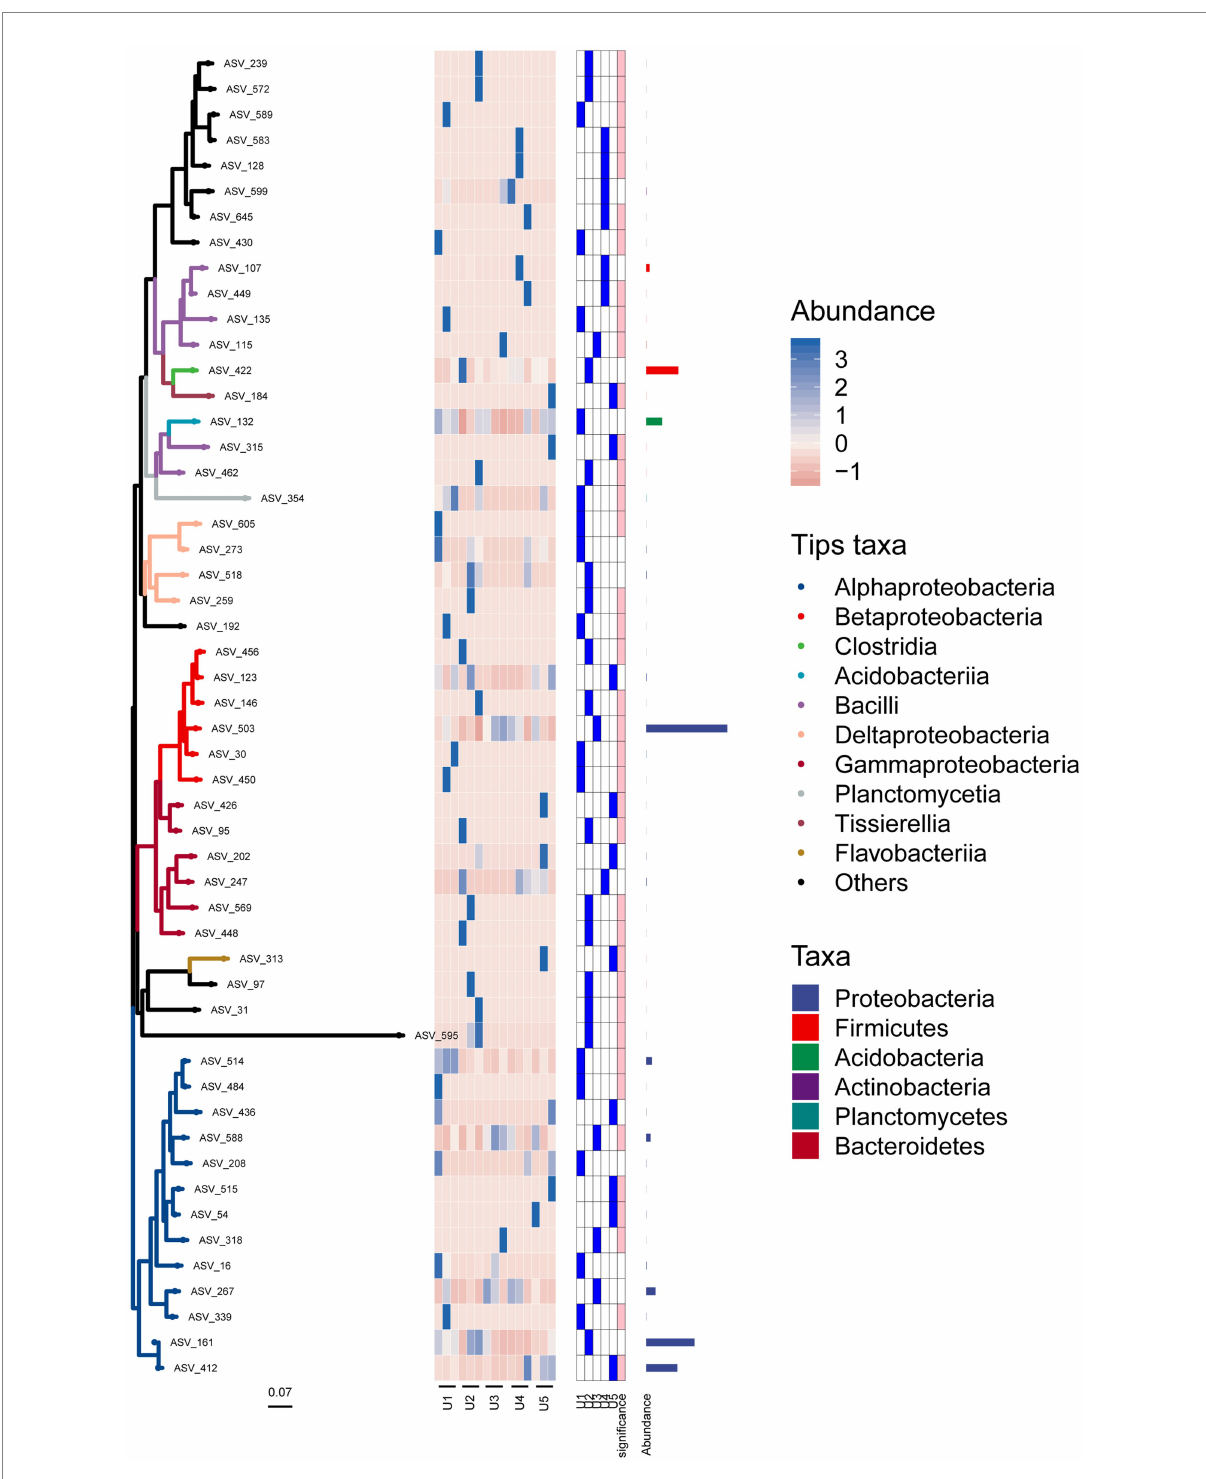
FIGURE 6 Position of each ASV associated with the endophytic bacterial community in the evolutionary tree. The heat map and bar chart reflect the composition, abundance, and taxonomic information of the bacterial community. Branches of different colors represent species of different